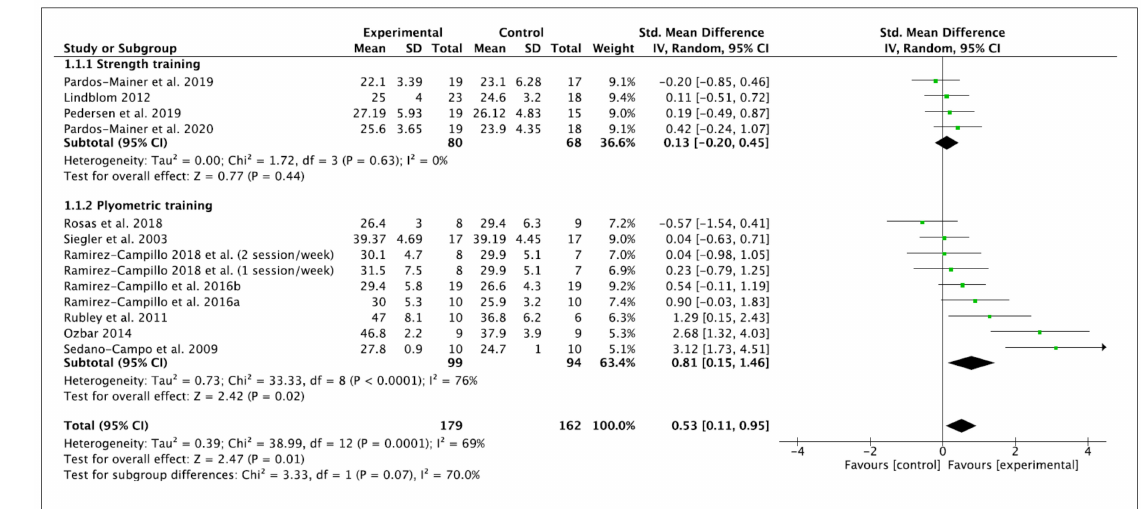
Figure 2. Forest plot of between-mode effect sizes with 95% confidence intervals (CIs) in vertical jump performance (cm). IV: inverse variance method; SD: standard deviation; Std: standardized.